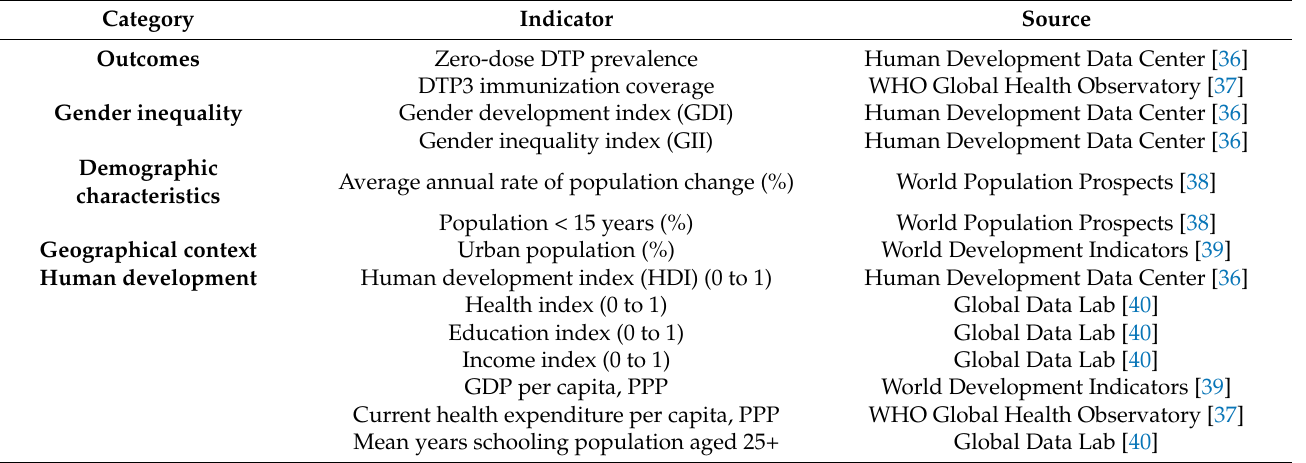
Table 1. Measures and data